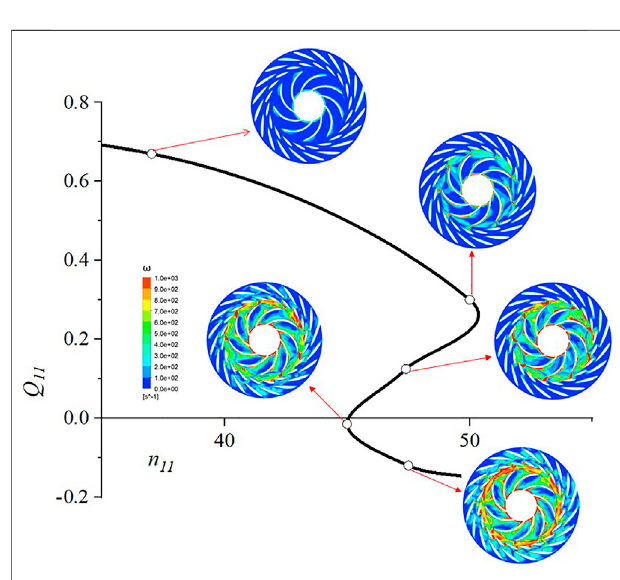
FIGURE 5 | Vorticity distribution.